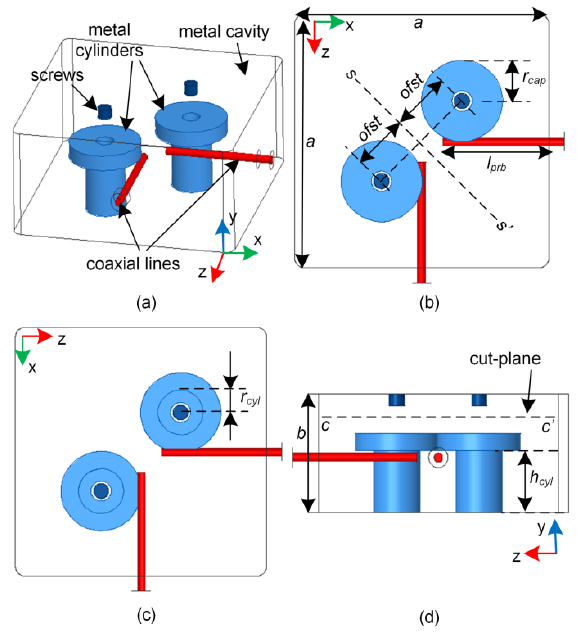
Figure 1. Structure of the proposed quadruple-mode filter ( a ) perspective view; ( b ) top view; ( c ) bottom view; ( d ) side view.